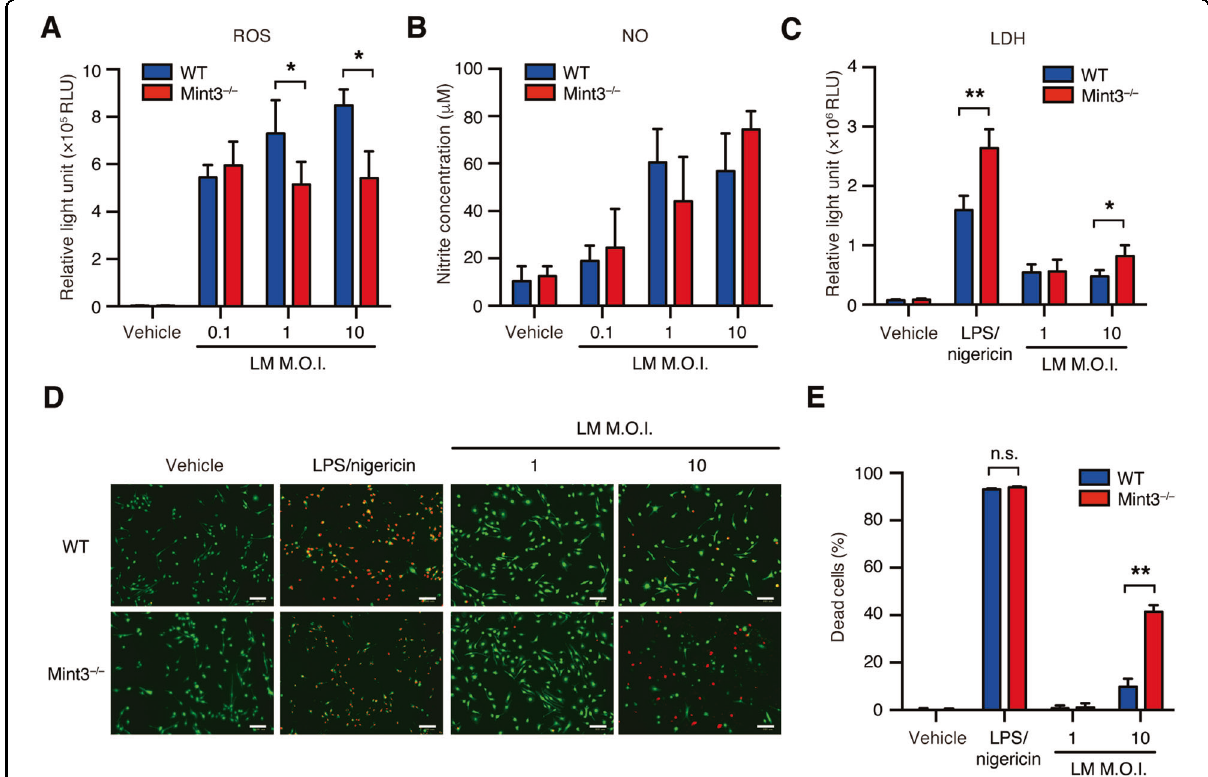
Fig. 3 Mint3 de fi ciency leads to decreased reactive oxygen species (ROS) production and increased cell death in LM-infected macrophages. Production of A (ROS) and B nitric oxide (NO) in WT or Mint3 – / – BMMFs. BMMFs from WT or Mint3 – / – mice were infected in vitro with LM (MOI = 0.1, 1, or 10). The production of ROS and NO was measured by luminometry 8 h after LM infection and Griess assay 12 h after LM infection, respectively. Data are presented as the means ± SDs of triplicates and are representative of two independent experiments. * P < 0.05 by the Student ’ s t -test. C – E LM-infection-associated cell death of WT or Mint3 – / – BMMFs. As a positive control, BMMFs were primed for 6 h with LPS (50 ng/mL), followed by stimulation for 2 h with nigericin (5 μ M). C Cell damage/death was assessed by quantifying the lactate dehydrogenase (LDH) content of the supernatant 12 h after LM infection. Data are presented as the mean ± SD of triplicates, and are representative of two independent experiments. * P < 0.05, ** P < 0.01 by Student ’ s t -test. D , E WT or Mint3 – / – BMMFs were stained using a LIVE/DEAD Cell imaging kit 12 h after LM infection. Live (green) and dead (red) cells were discriminated using fl uorescence microscopy. D Representative photographs. Scale bars = 100 μ M. E Quanti fi cation of the ratio of dead cells in total cells. n = 3 per group. * P < 0.05, ** P < 0.01 by Student ’ s t